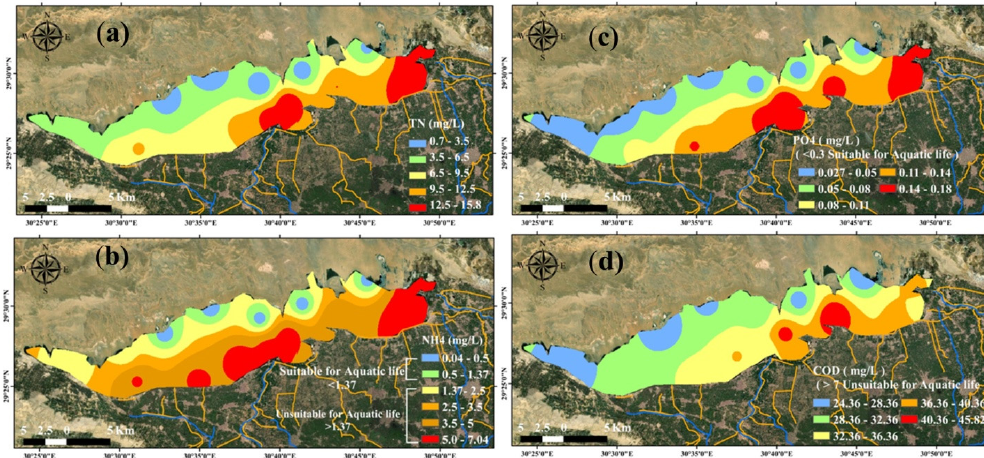
Figure 3. Spatial distribution maps of WQPs in 2019: ( a ) total nitrogen (TN), ( b ) ammonium (NH 4+ ), ( c ) orthophosphate PO 43 − , and ( d ) chemical oxygen demand COD. Table 4. Classification of surface water in Lake Qaroun compared to guidelines of drinking utilization and aquatic life protection, according to WQPs over two years. WQPs